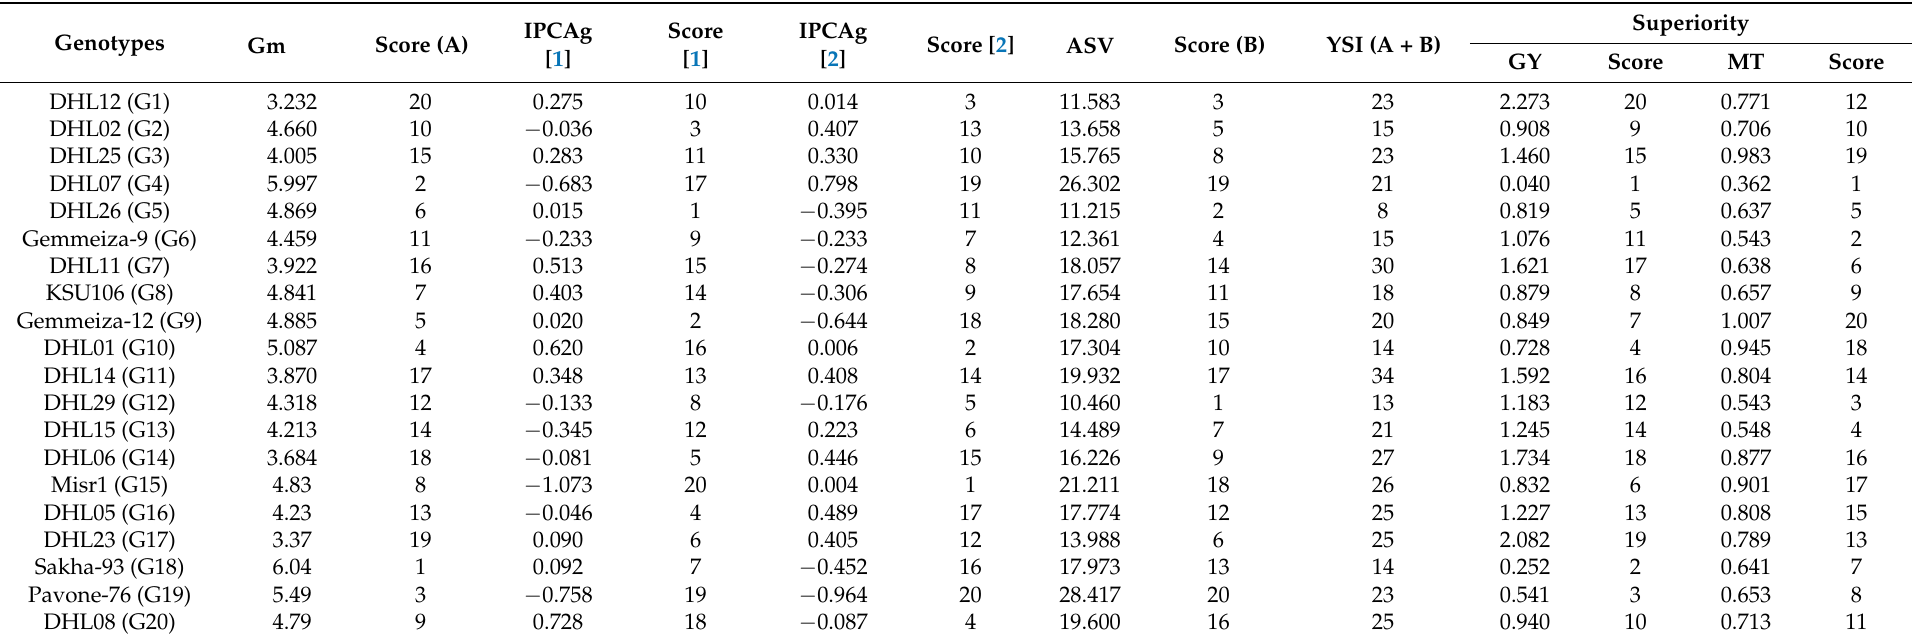
Table 6. Mean grain yield (t/ha), AMMI stability values (ASV), superiority, and ranking orders of the 20 wheat genotypes tested across six